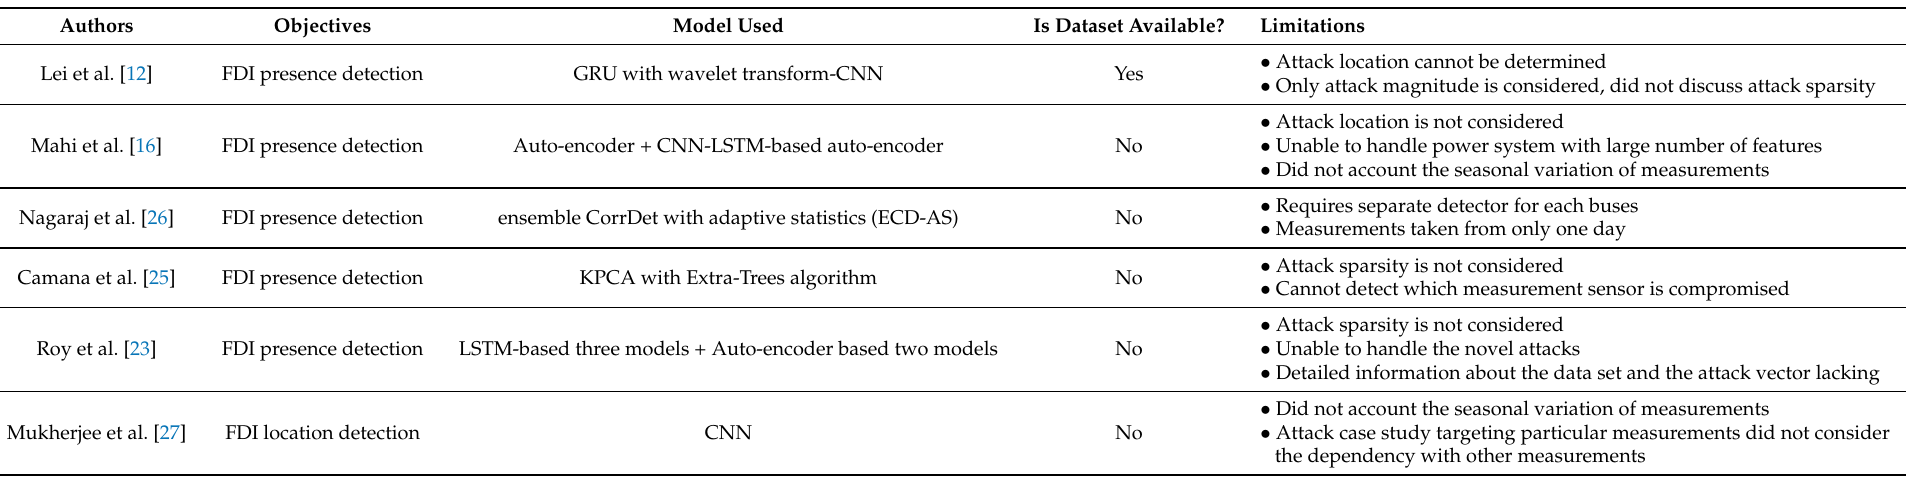
Table 1. Recent Research on FDI attack in smart